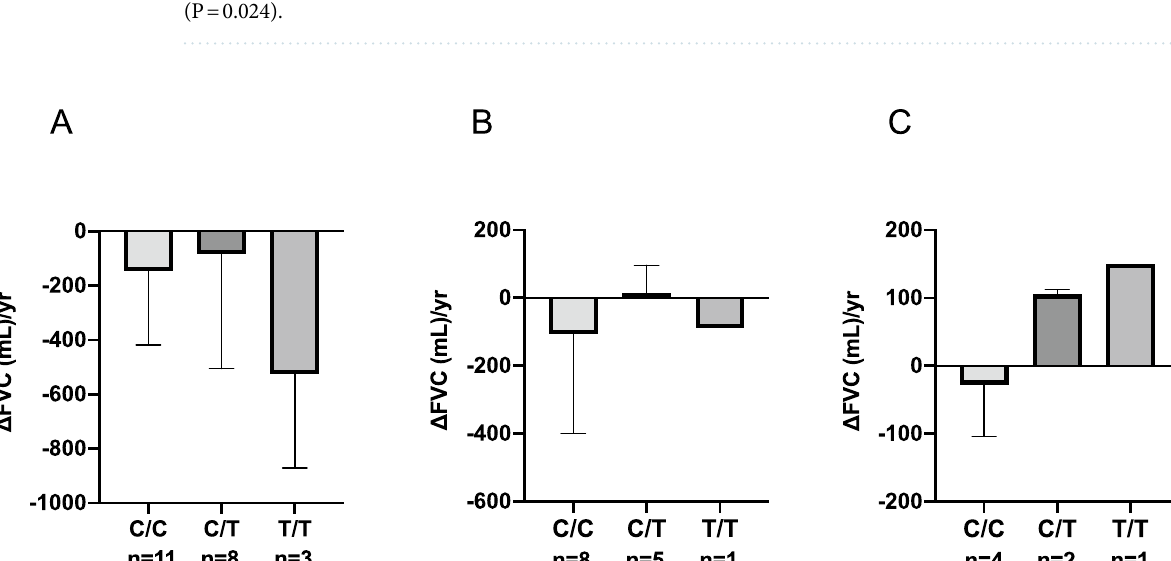
Figure 4. Change in forced vital capacity (FVC) from baseline to 1 year after the start of antifibrotic therapy, by rs3750920 genotype. (A) Patients treated with nintedanib (n = 22). (B) Patients treated with pirfenidone (n = 14). (C) Patients treated with inhaled N -acetylcysteine (n =